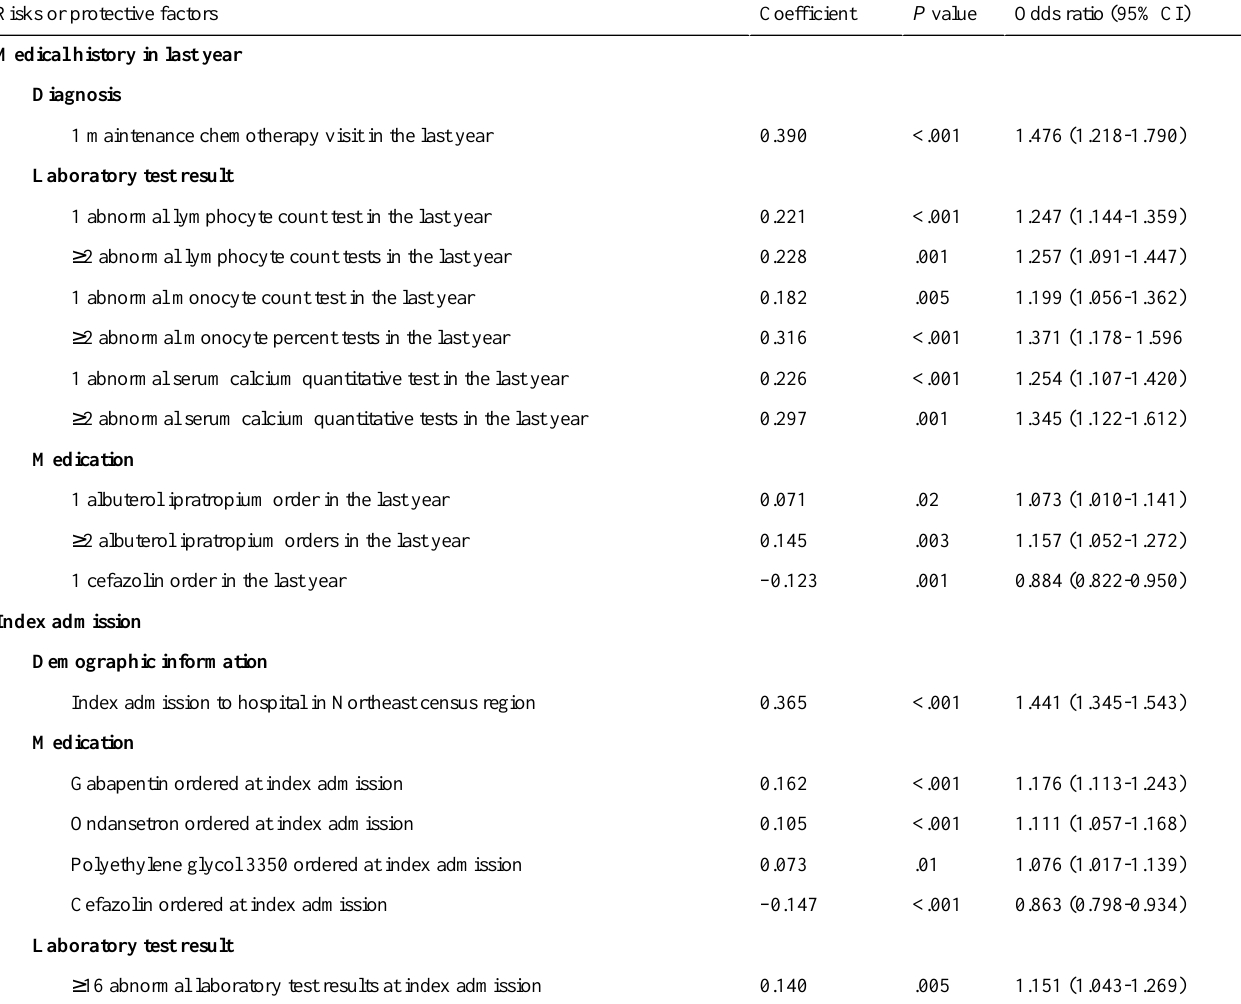
Table 5. The 14 novel risk factors and 2 novel protective factors of readmission identified in the